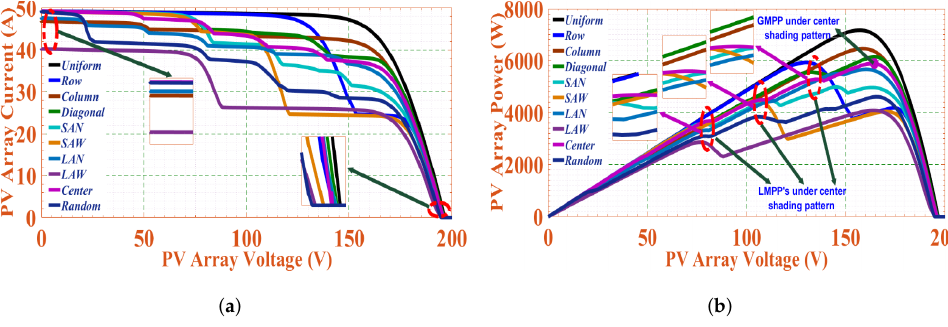
Figure 7. Results of H-C topology under various PSCs. ( a ) I-V characteristics, and ( b ) P-V characteristics.